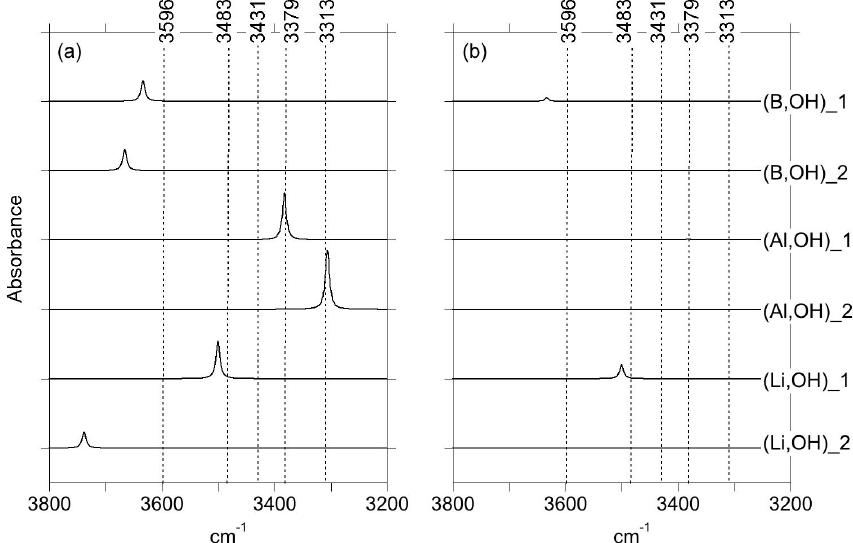
Figure 3. Theoretical IR absorption spectra of selected OH-bearing defects associated with chemical impurities for polarizations perpendic- ular (a) and parallel (b) to the [001] direction. The positions of the experimentally observed IR bands (Fig. 1) are indicated by the dotted